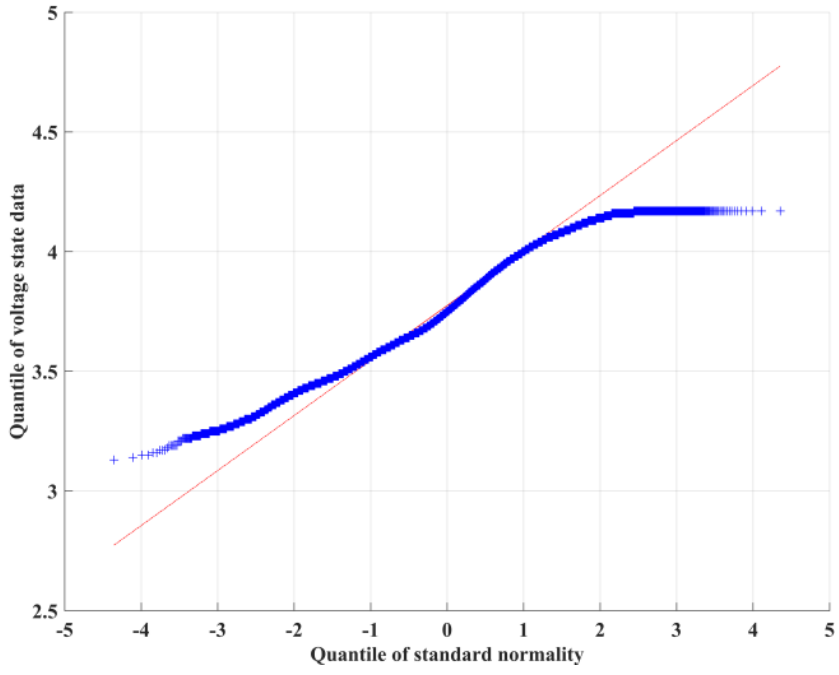
Figure 3. Q − Q diagram of voltage data.